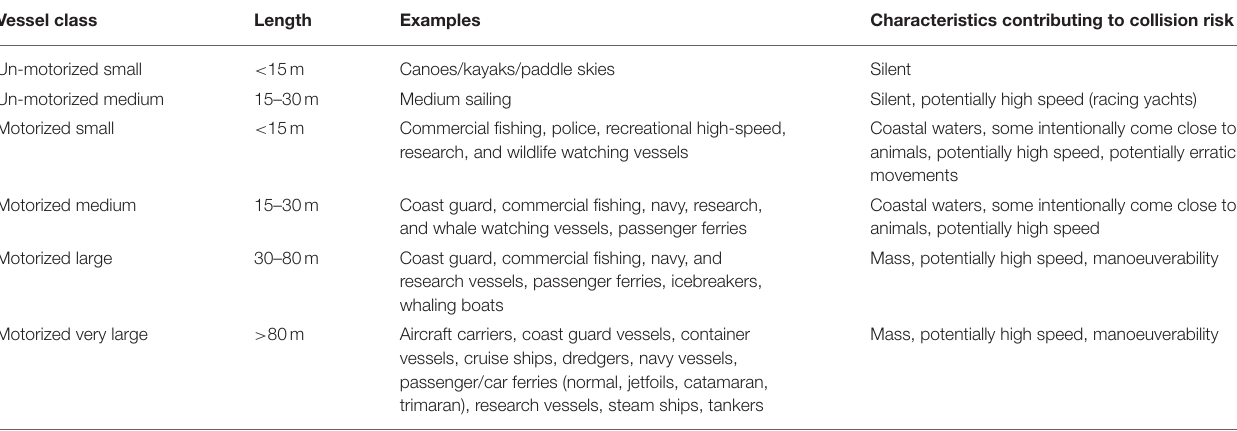
TABLE 2 | Summary of vessel classes involved in collisions with marine animals, including their typical length in meters (modified after Laist et al., 2001; Lammers et al., 2003; Neilson et al., 2012) and characteristics contributing to collision